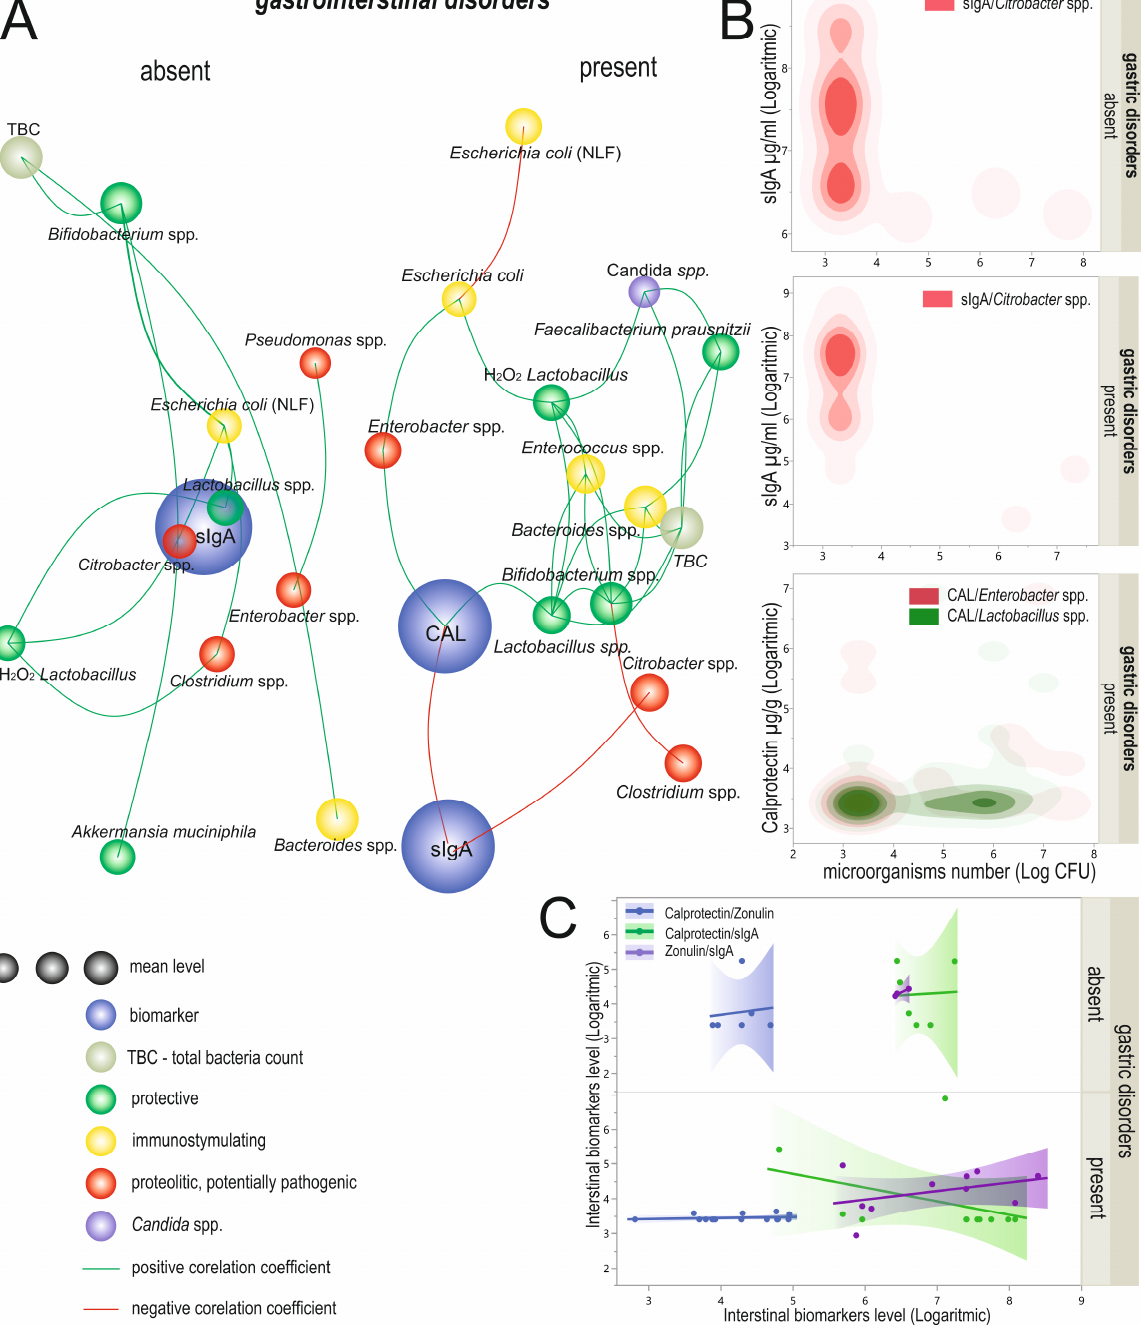
Figure 7. Linkage distances between analyzed biomarkers and selected microorganisms in groups distinguished according to probiotics usage ( A ). The length of each line represents the strength of the correlation coefficient. In the case of the circle diameter of microorganisms, the circle size represents the mean level. The biomarker circle size was not scaled. Significant correlations of analyzed biomarkers and microorganism species ( B ) and correlation between logarithmic transformed biomarkers’ levels ( C ). CAL—calprotectin; sIgA—secretory immunoglobulin A; ZON—zonulin; TBC—total bacteria count; NLF—non-lactose fermenting; Log CFU—logarithmic transformed colony-forming units.